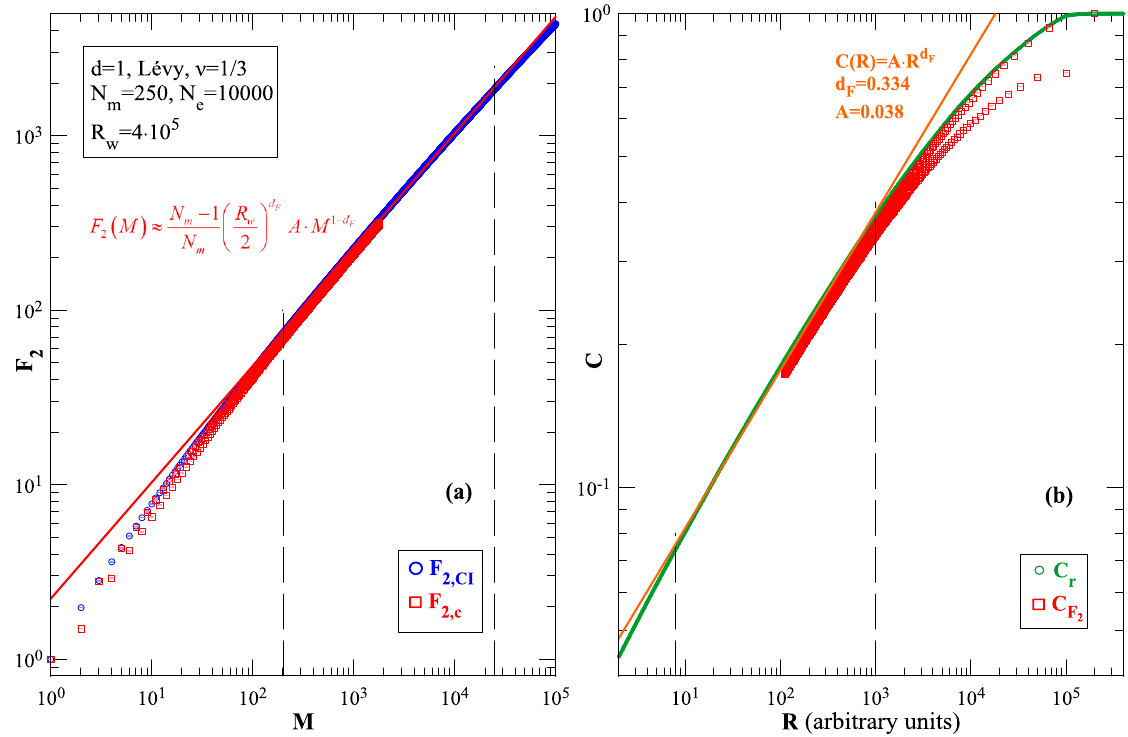
Fig. 7 Analysis of a Lévy data set of N e = 10 , 000 events and multiplicity N m = 250 in an embedding space of d = 1